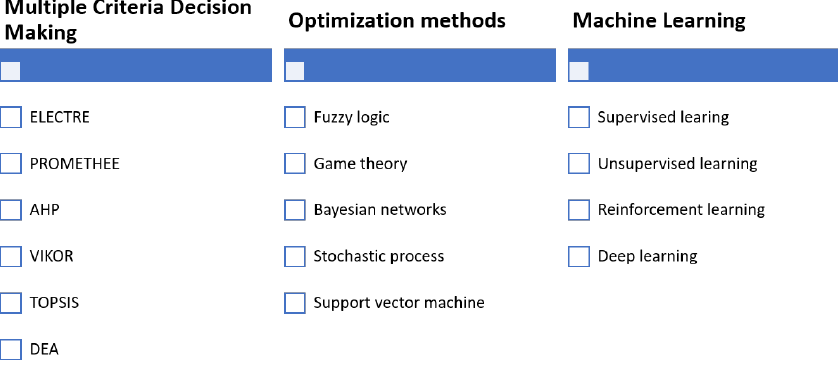
Figure 3. Classification of computational methods for decision-making.